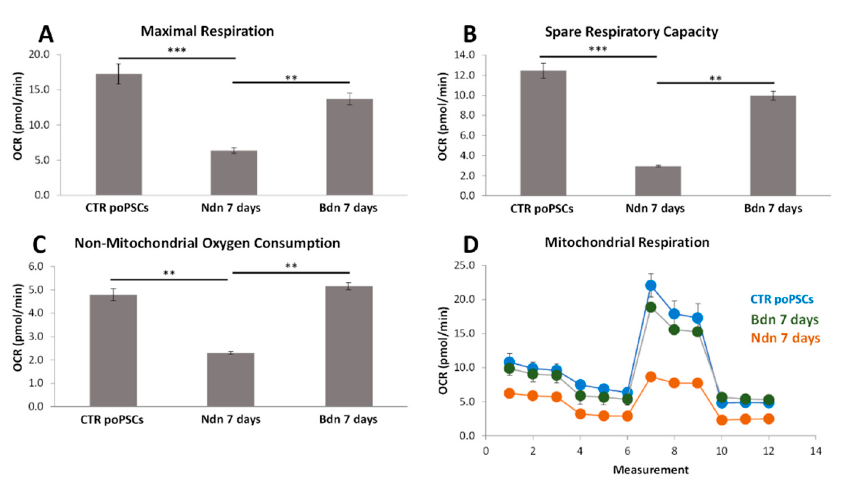
Figure 7. Seahorse XF Cell Mito Stress Test: The graphs show representative oxygen consumption rates (OCR) in mitochondrial respiration ( D ) broken down into maximal respiration ( A ), spare respiratory capacity ( B ), and non-mitochondrial oxygen consumption ( C ). Mitochondrial respiration was measured as OCR in poPSCs cultured for 7 days in the presence of nandrolone or boldenone. The obtained results were compared to the OCR level obtained on poPSCs cultured without the addition of these anabolic steroids (control). Results represent the mean with n = 4 ± standard deviation (SD). Statistical analysis: homogeneity of variance—Levene’s test, normality of distribution—Shapiro–Wilk test, one-way ANOVA, Tukey’s post-hoc test, ** p < 0.01; *** p < 0.001.